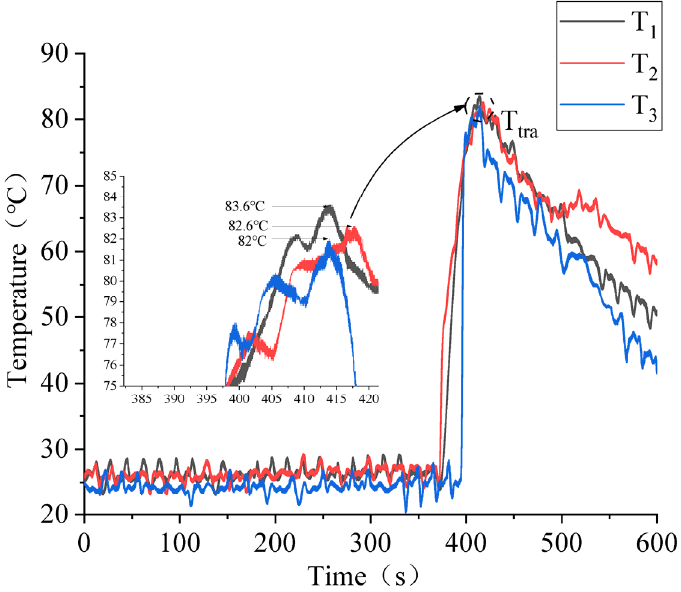
Figure 3. Same SOC battery time temperature curve.